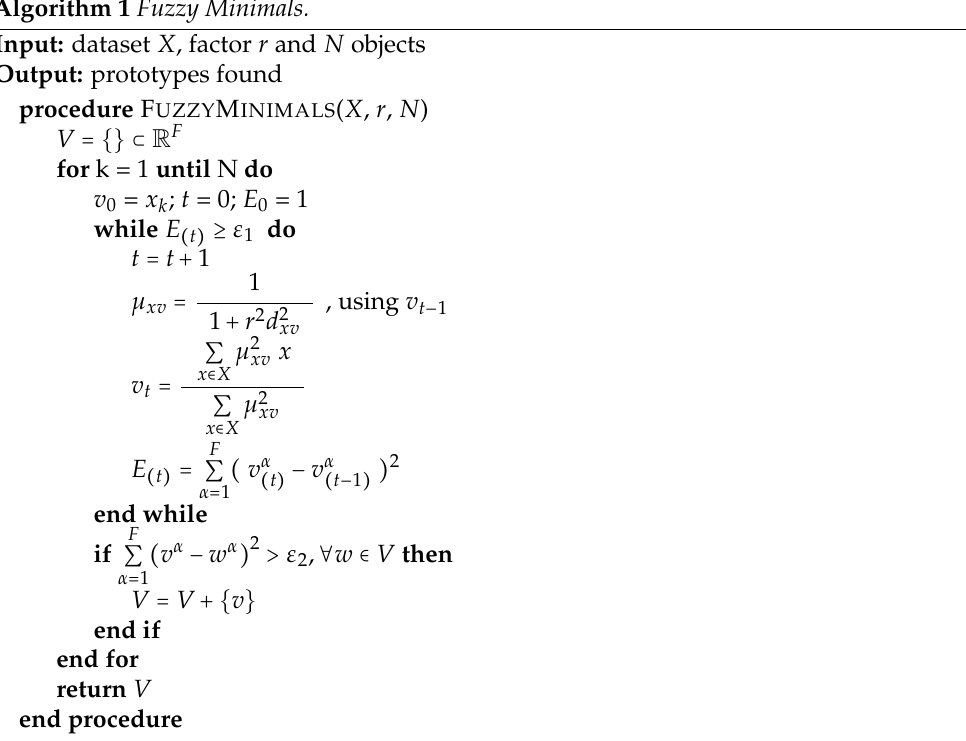
Algorithm 1 Fuzzy